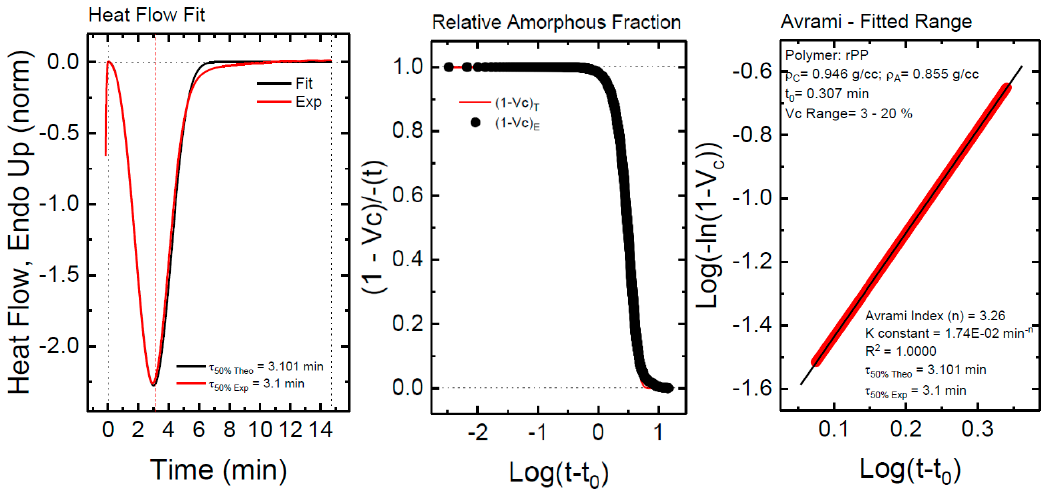
Figure 12. ( a – c ) Comparison between experimental data and the fits to the Avrami equation using the Origin plug-in developed by Lorenzo et al. [32]. Origin plug-in developed by Lorenzo et al.